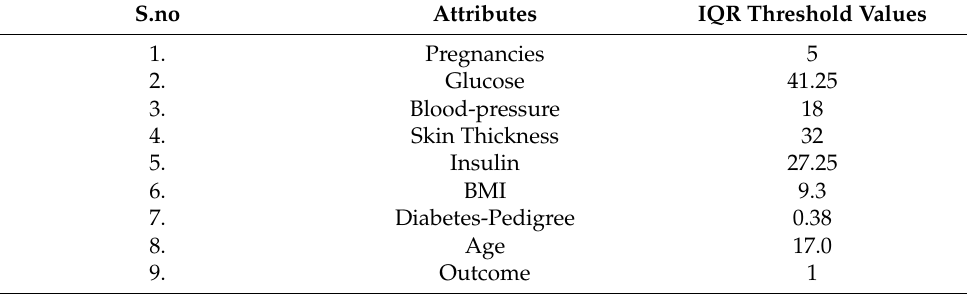
Table 3. IQR values for PIMA Indian dataset.